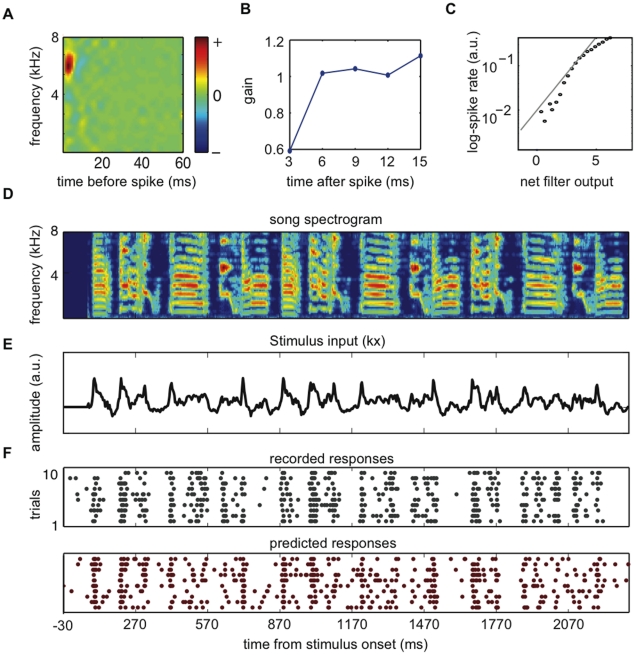
A GLM as a neural encoding model.(A)–(B) Estimated parameters for an example auditory midbrain neuron. (A) STRF. (B) Exponentiated post-spike filter, which may be interpreted as a spike-induced gain adjustment of the neuron's firing rate. It produces a brief refractory period and gradual recovery (with a slight overshoot). (C) Estimate of the nonlinearity transforming linear input to instantaneous spike rate (black points), for the same example neuron (Chichilnisky 2001). The nonlinearity represents the probability of observing a spike for each value of net linear input (b+k*x+h*r). An exponential function (grey line), the assumed nonlinearity for the model, provides a reasonable approximation to this function. (D) Spectrogram (x) of one example song used in the experiments. (E) Stimulus filtered by STRF, k*x. (F) Recorded (gray) and predicted (red) raster plots in response to the validation stimulus shown in (D).